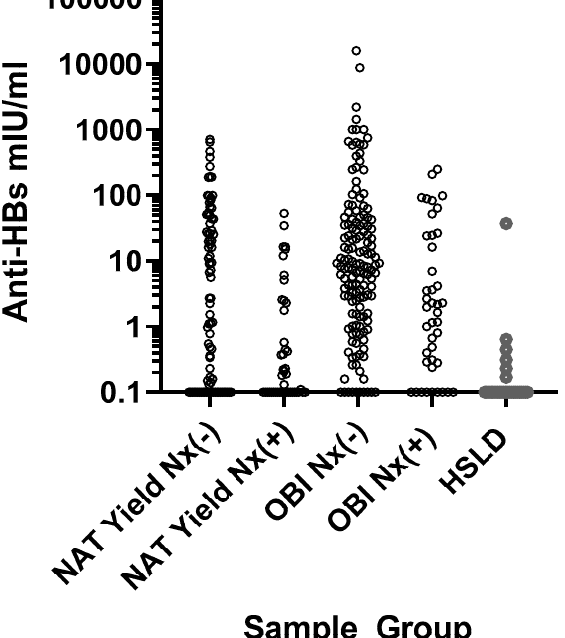
Figure 2. Anti-HBs levels in NAT yield, OBI, and HSLD samples: HBsAgNx-negative NAT yield (N = 87), HBsAgNx-positive NAT yield (N = 44), HBsAgNx-negative OBI (N = 146), HBsAgNx-positive OBI (N = 42), HSLD (N = 28). Values ≥ 10 mIU/mL were considered positive for anti-HBs.